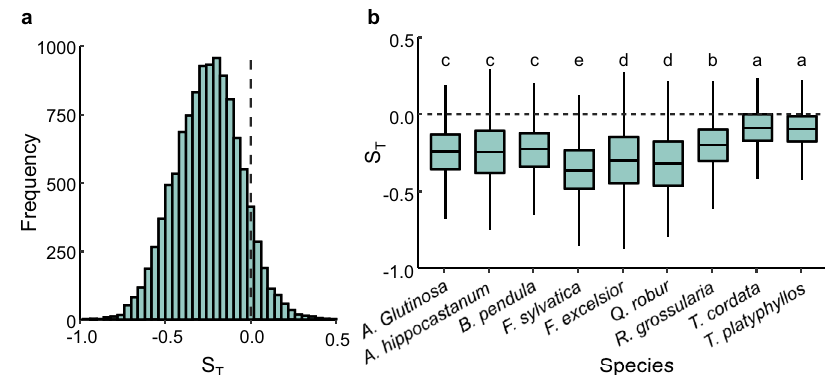
Fig. 2 Temperature sensitivities (S T , change in days per degree Celsius) of start of season (SOS) in the current year in response to increasing temperature during previous growing season based upon PEP725 dataset. The calculated S T was based upon records of spring leaf unfolding for 9 temperate tree species at 2322 sites in Europe. a Distribution of the calculated S T across all species and sites ( N = 11,369). b Difference in the S T among tree species. The black dash lines indicate when S T is equal to zero. The box spans from the fi rst to the third quartile, with intermediate values marked as the black line in the middle of the box. One-way analysis of variance (ANOVA) followed by Tukey ’ s honestly signi fi cant difference (HSD) test was used to test the difference in the S T between species, two-sided test was used to calculate P values and different letters indicate signi fi cant differences ( P < 0.05). The sample size and calculated P values were listed in Supplementary Tables 2, 3.